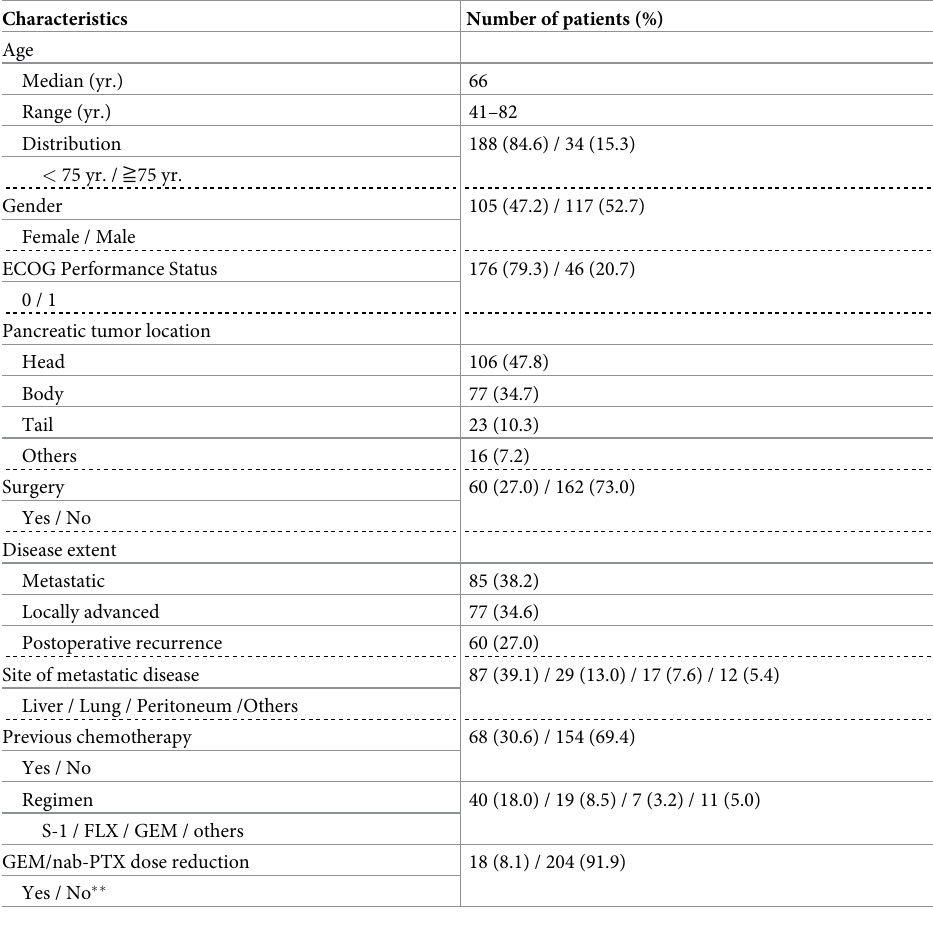
Table 1. Characteristics of patients at